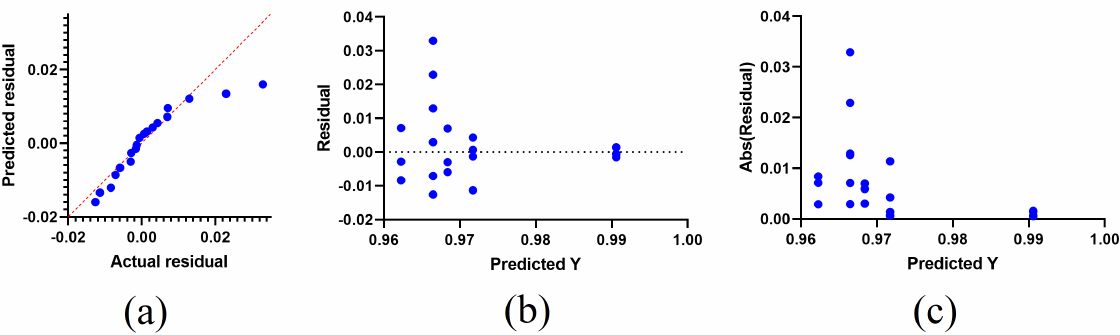
Figure 13. Analysis plots of the achieved classification results based on a neural network optimized using the proposed SCBER algorithm. ( a ) QQ plot, ( b ) Homoscedasticity plot, ( c ) Residual